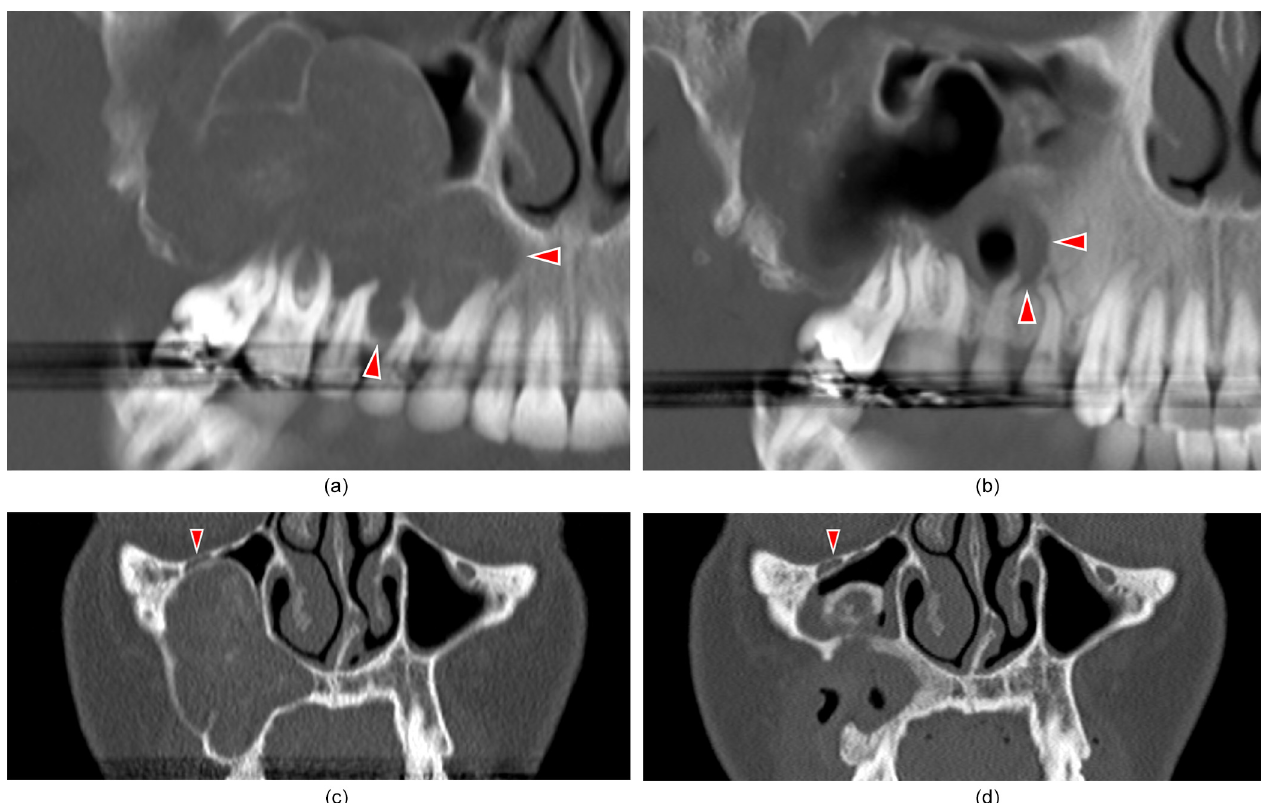
Fig. 2. 3D imaging of a right maxillary OKC in a 37-year-old female. (a) Before the protocol, the lesion extended to the centerline of the second incisor; lobes creeped into the alveolar bone down to the tooth collars. (b) After 14 months of decompression, both the incisor and the canine are away from the OKC. Only the apices of the 4 posterior teeth still have their apices inside the cyst. After root fi lling of these teeth, the next step was enucleation of the lesion, together with apicectomies of these teeth for a better peripheral burring of the cavity. Without the decompression protocol, 5 teeth would have been lost in a one-step surgery. Notice the presence of air in the cavity, because of the drain. (c) Before the protocol, the infraorbital nerve was fl attened by the OKC. (d) After 14 months of decompression, surgery could be performed with a lower injury risk to the infraorbital nerve, away of the